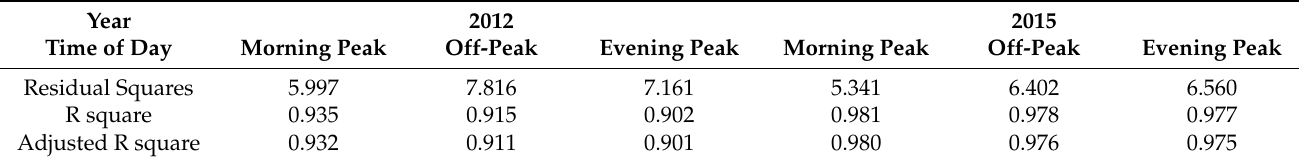
Table 5. Results of the TDA to household